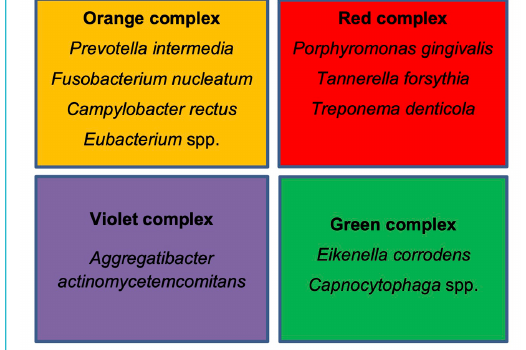
Figure 2: Bacterial complexes in periodontitis. The colours indi- cate different pathogen groups in the development of periodontitis. The orange complex includes pathogens important to the initiation of periodontal disease. The red complex includes pathogens with a highly inflammatory capacity. Pathogens of the green complex usually have a high local persistence and destruction potential and pathogens of the purple complex have several strong virulence factors that cause cell death and trigger or evade